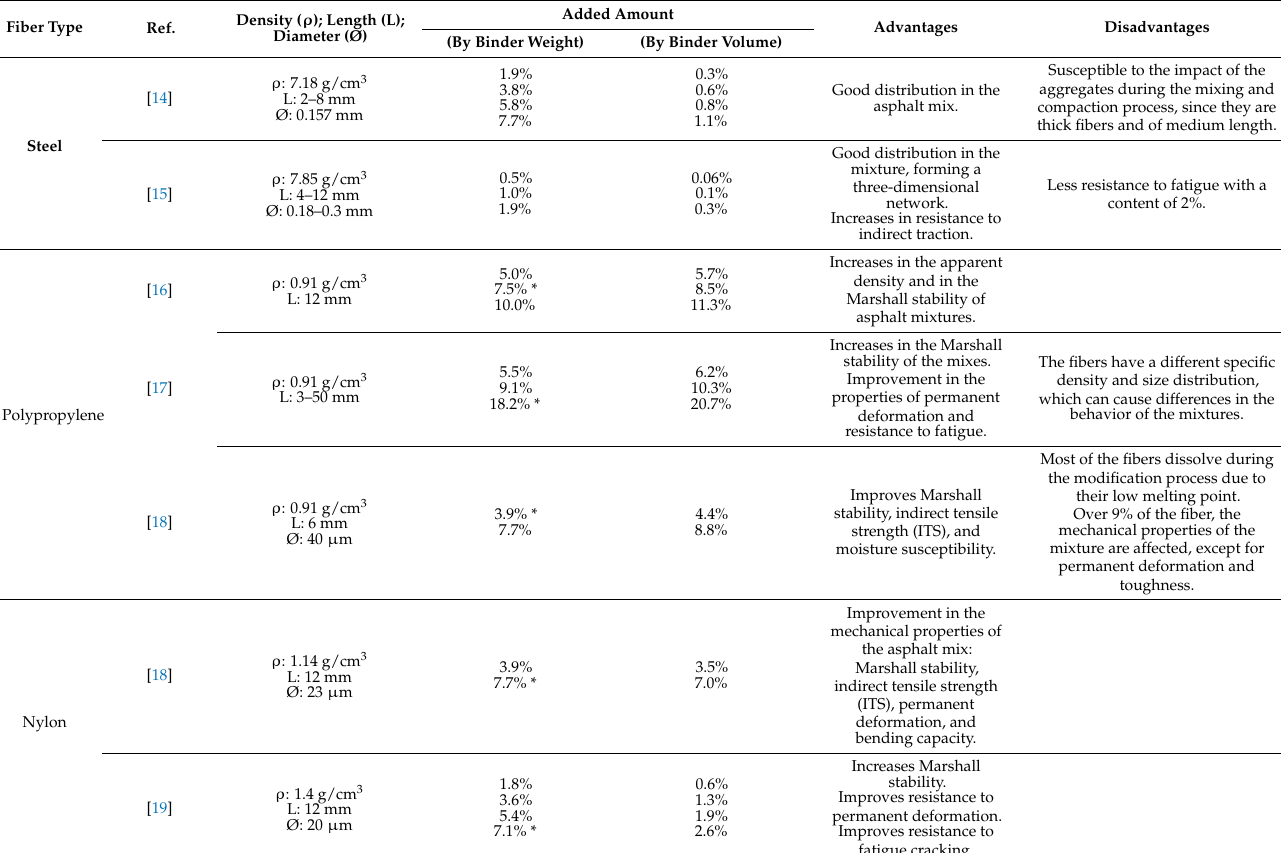
Table 1. Different fibers applied in asphalt mixes.